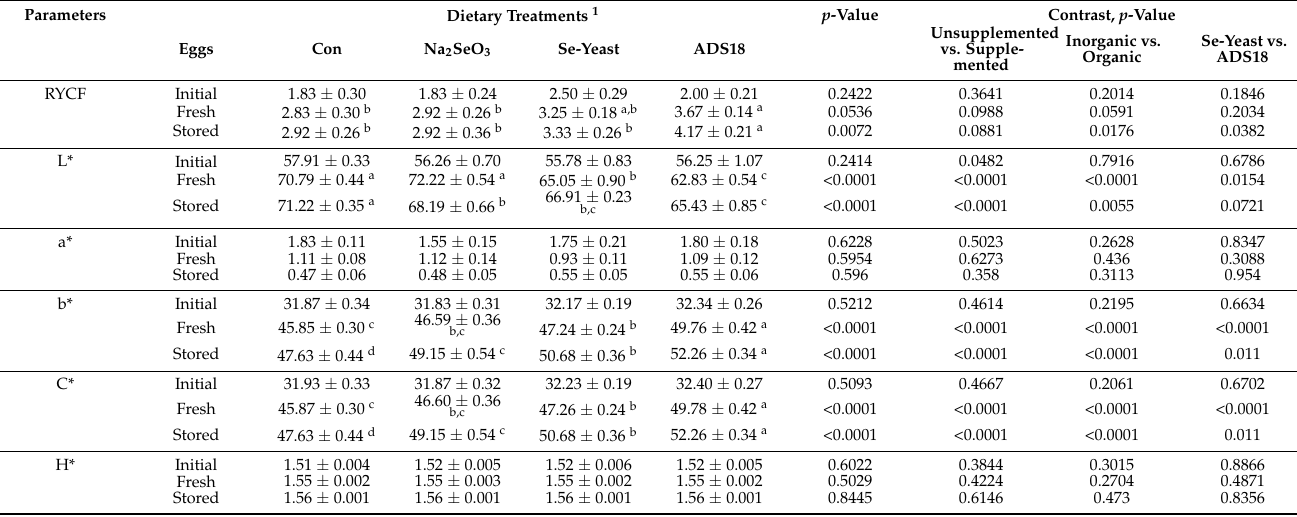
Table 2. Egg yolk coloration before and after storage at 4 ± 2 ◦ C for 14 days of laying hens supplemented with sodium selenite, selenium yeast, and bacterial organic source.